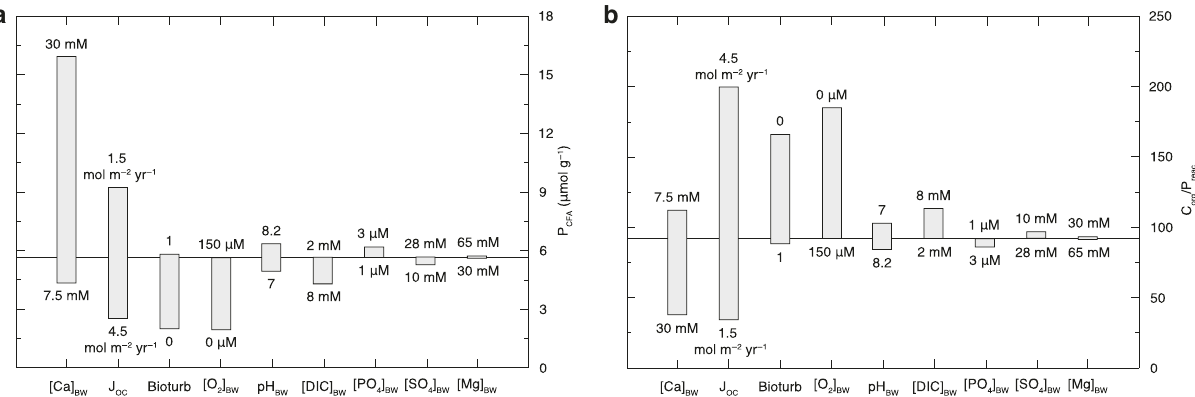
Fig. 3 In fl uence of environmental factors on CFA burial. a The effect of environmental forcings on CFA burial. The y axis denotes the concentration of CFA-associated P in sediments. b the effect of environmental forcings on the burial ratio between organic carbon and reactive P. The horizontal line represents the value for the shallow marine reference model run (see Supplementary Methods). All parameters were held constant, apart from the individual parameter varied for each sensitivity analysis. Bioturb is a coupled biodiffusion and bioirrigation term and J oc is the fl ux of organic matter to the sediment-water interface.